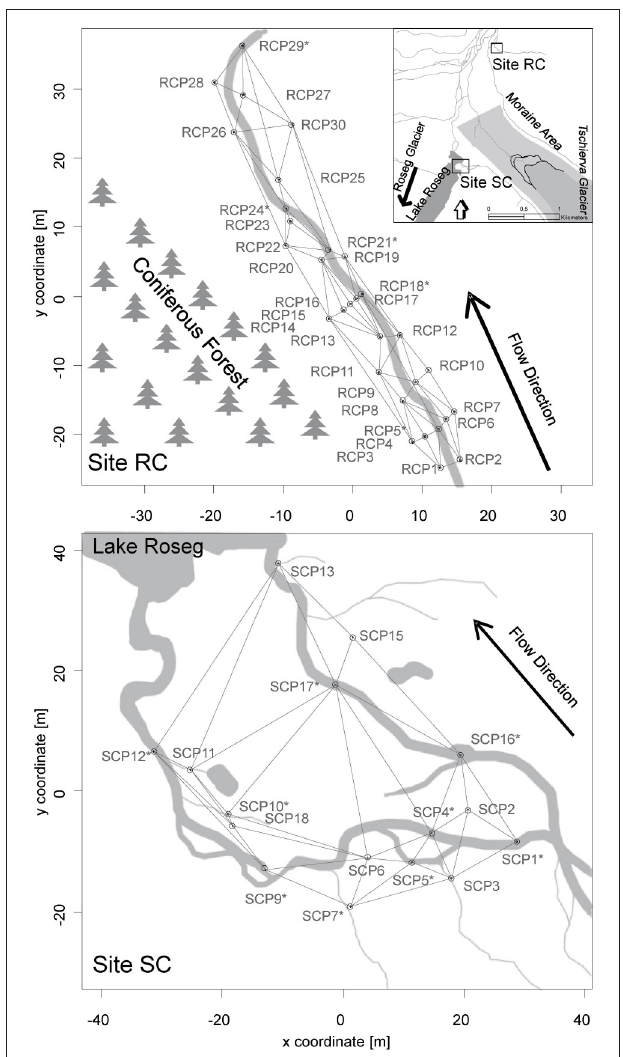
FIGURE 1 | Maps of the Val Roseg catchment and locations of the study floodplains with the upper panel showing site RC and the lower panel showing site SC. Locations of piezometers in each floodplain relative to each stream, the direction of flow paths, and the spatial connectivity grid used for the AEM and MEM models are depicted. Asterisks depict piezometers located in-stream.